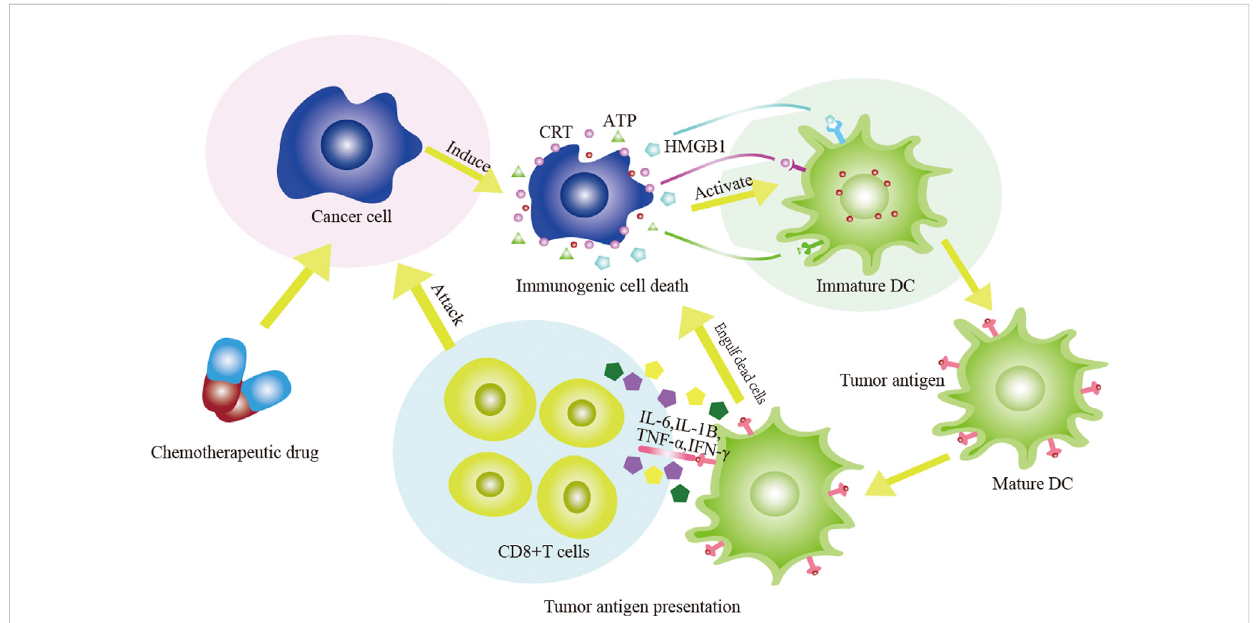
FIGURE 1 The diagram of chemotherapeutic drugs act on tumor cells to induce ICD. The chemotherapeutic drugs stimulateDC to phagocytose antigensand induce DC to mature through therelease of a large number of damps. The effect of DC on T cells includes two aspects: DC directly acts on CTL; DC acts on CTL again by secreting IL-6, IL-1 β , IFN- γ and TNF- α . The adaptive immune response is subsequently activated and the anti-tumor effect of chemotherapy drugs are enhanced.